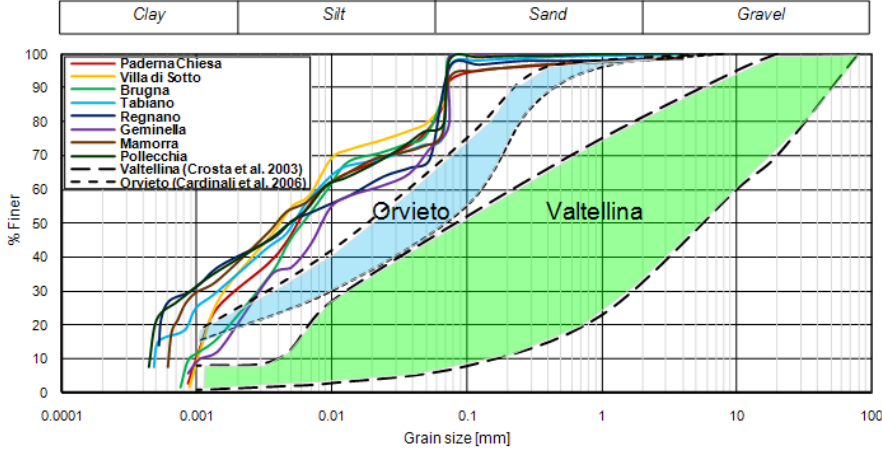
Fig. 4. Grain size distribution curves of shallow soils involved in soil slips in 8 sample sites of the test-area, compared with those of other